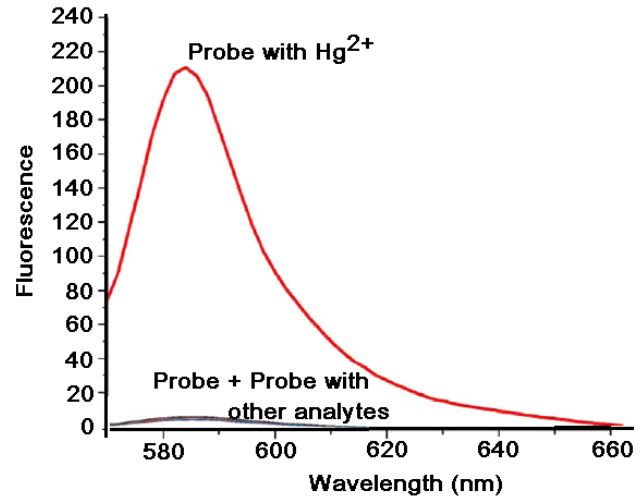
Figure 6. Fluorescence response of VRF probe (10 µM) in the presence of Hg 2+ and other metals ions (100 µM) in CH 3 CN/HEPES buffer solution (1:1, v / v , 0.1 M, pH = 7.4); excitation wavelength = 560 nm, emission wavelength = 585 nm.